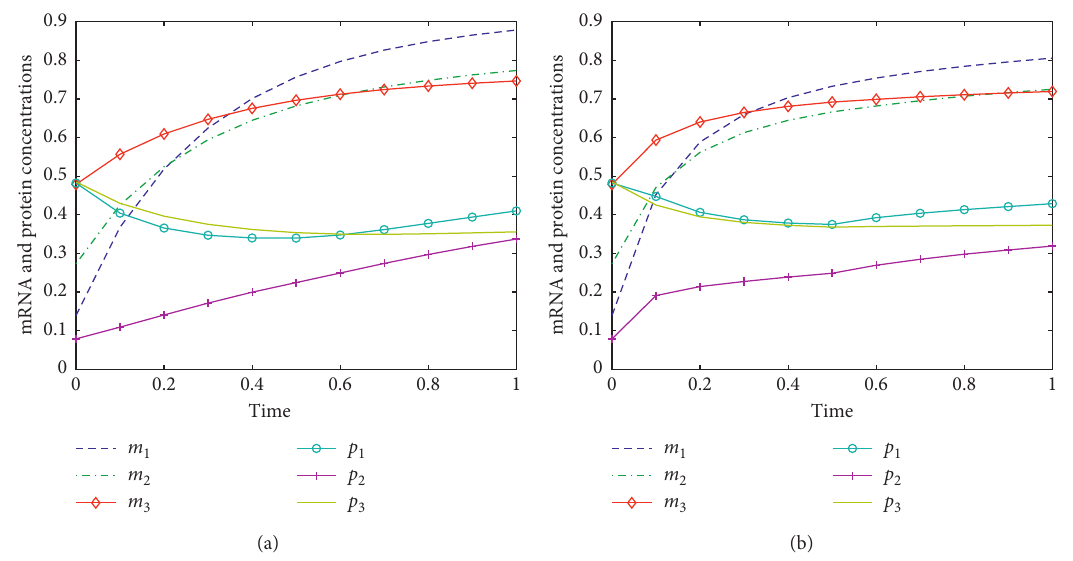
Figure 4: Transient states of DFGRN (64) with (a) q � 0 . 95 and (b) q � 0 .